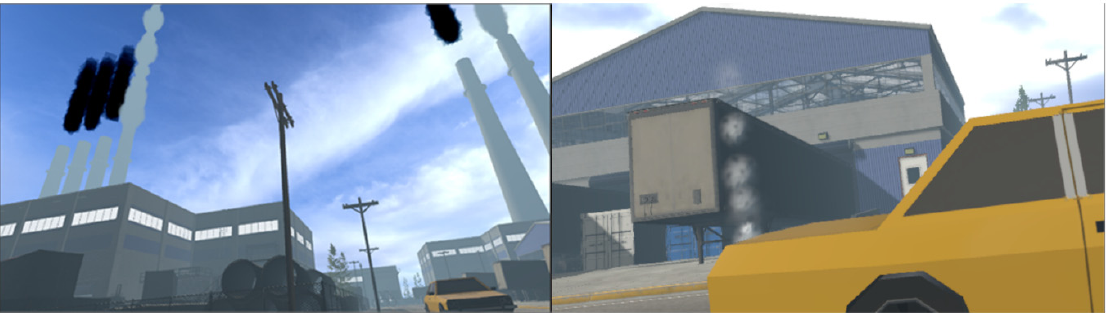
Figure 4. Causes of global warming, such as factory smoke (left) and automobile fumes (right), since industrialization in the 1970s.